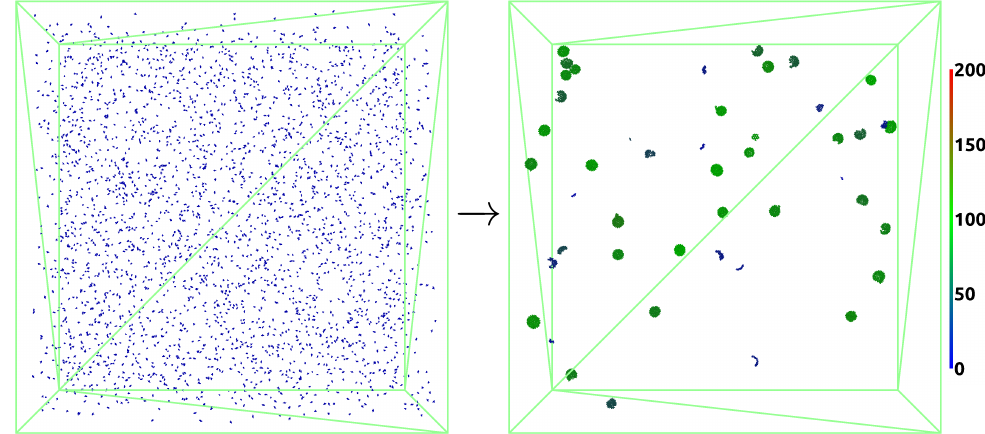
Figure 11. Self-assembly of VLPs during 5 ms simulated using MDEM with SP3 simulation protocol (box of 1 µm 3 , protein concentration of 5 µ M ). The size of assemblies formed ( N SAS ) is depicted using the designed color scheme and the backbone carbon atom